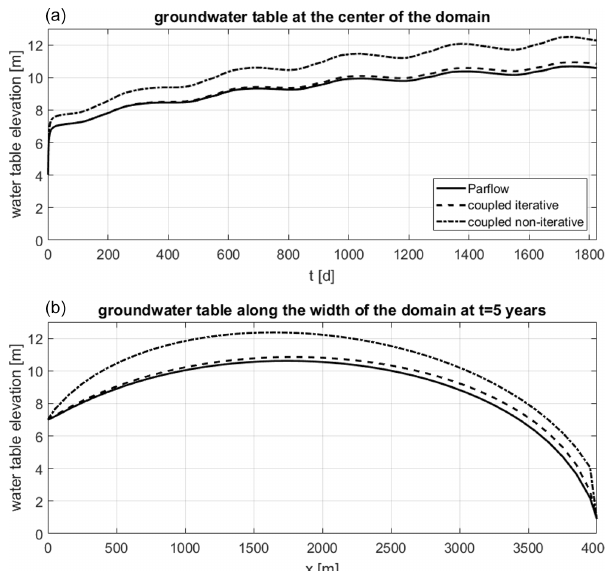
Figure 10. Results of the 2D flow problem. (a) Groundwater table elevation over time in the center of the domain. (b) Groundwater table along the width of the domain at the final time